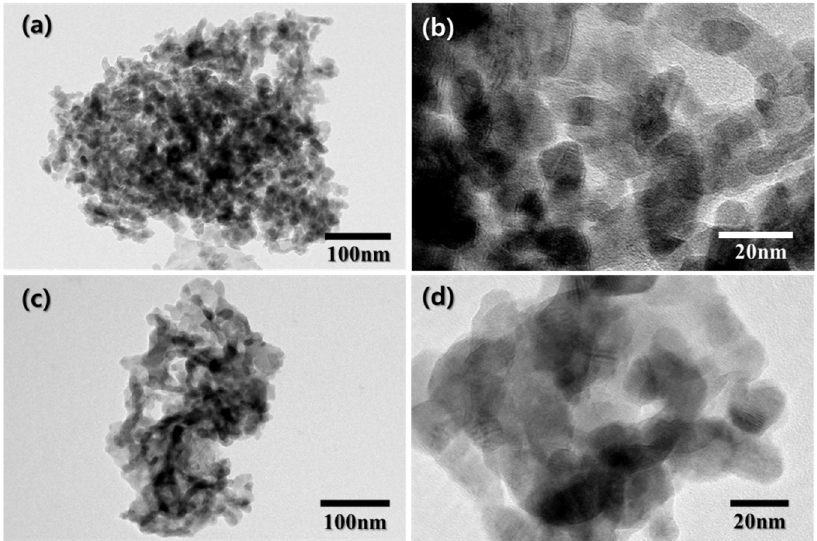
Figure 3. TEM images of ( a ) MnNPs, ( b ) MnNPs at high magnification, ( c ) MMN, and ( d ) MMN at high magnification.